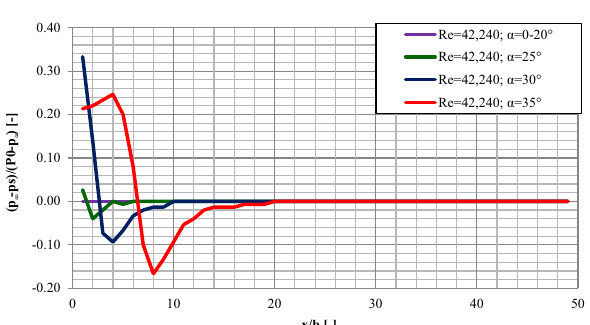
Figure 7. The pressure distributions on the plate—examined in the direction of attachment Re = 42,240; (where static pressure on the surface of the inclined flat plate (ps); stagnation pressure of the fluid supplying the jet (P 0 ); static pressure of the surrounding fluid at rest